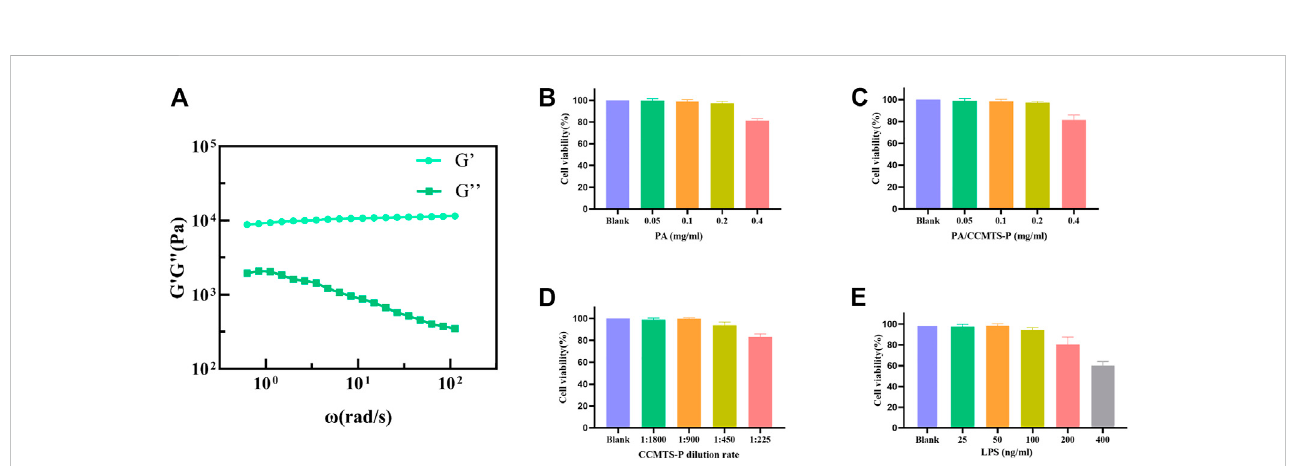
FIGURE 2 Characterization of PA/CCMTS-P and the results of cell viability assay. (A) Rheological property of PA/CCMTS-P, and G ′ represents the elastic property while G ″ represents the viscous property. (B – D) cytotoxicity of the PA stock solution, CCMTS-P and PA/CCMTS-P at different concentrations to Raw264.7 cells at 24 h. (E) The cytotoxicity of LPS to Raw264.7 cells after 24 h